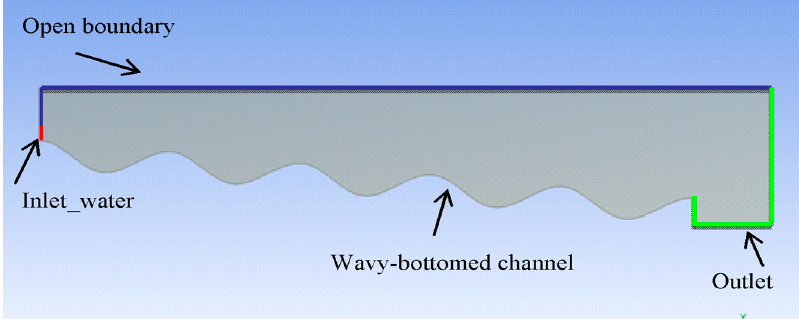
Figure 2. Model geometry and boundary conditions of the photobioreactor at slope 6°.